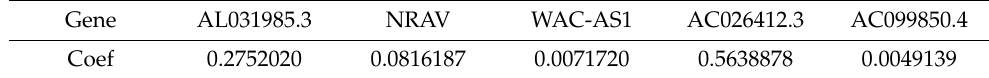
Table 1. m1A-related lncRNA risk model parameters.